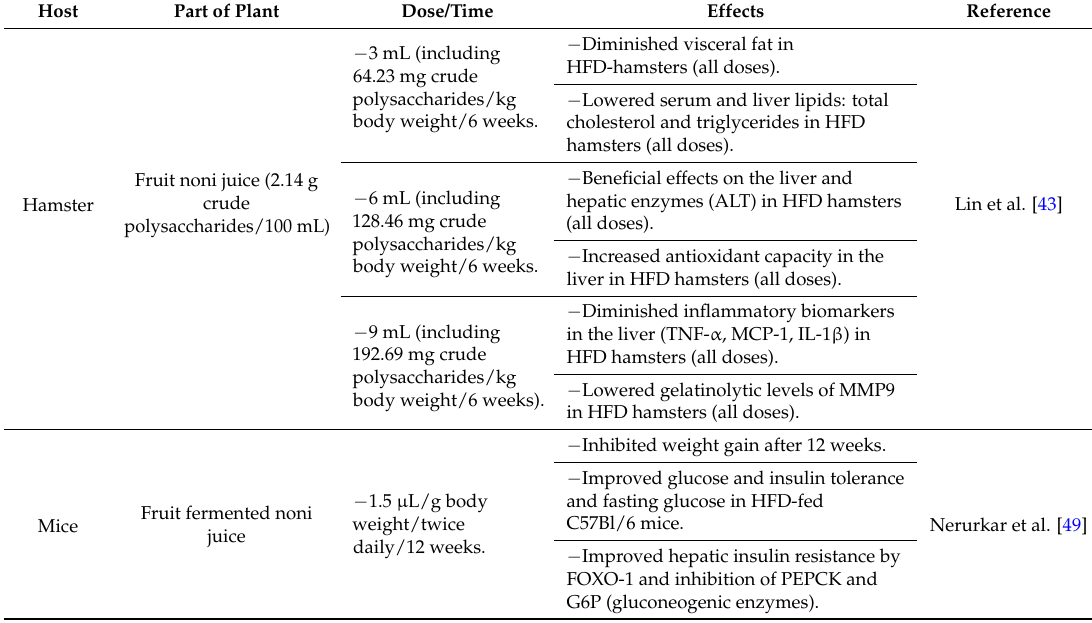
Table 4. Effects of the administration of the Morinda citrifolia L. plant on non-alcoholic fatty liver disease